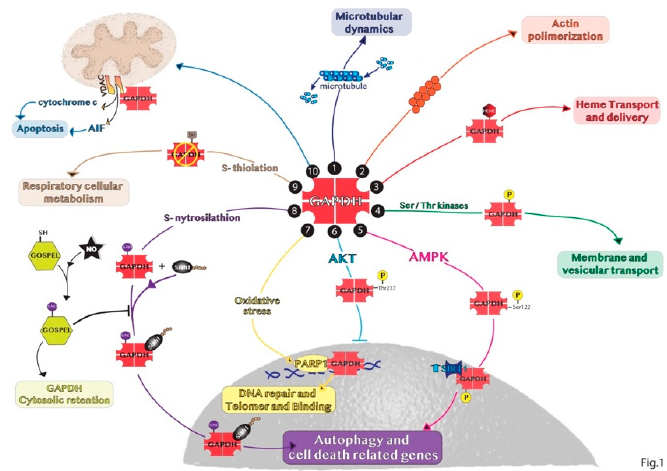
Figure 1. Representative summary of the non-glycolytic roles of GAPDH. (1) GAPDH interaction with microtubule helps in microtubular dynamics. (2) GAPDH favors actin polymerization. (3) GAPDH acts as chaperone with endogenous and exogenous heme. (4) GAPDH phosphorylation is involved in early secretory pathway transport. (5) In response to glucose deprivation, activated AMPK phosphorylates GAPDH in the cytosol inducing GAPDH translocation to the nucleus and its binding with SIRT1 promoting autophagy. (6) GAPDH phosphorylation by AKT blocks the translocation of the enzyme to the nucleus. (7) In the nucleus, GAPDH binds to PARP1 or damaged DNA to induce DNA repair. (8) SNO-GAPDH binds Siah1 and the complex translocates into the nucleus inducing cell death related genes. (9) GAPDH glycolytic activity can be inhibited by S-thiolation increasing respiratory cellular metabolism. (10) GAPDH binds VDAC1 channel favoring apoptosis by releasing cytochrome c and AIF.